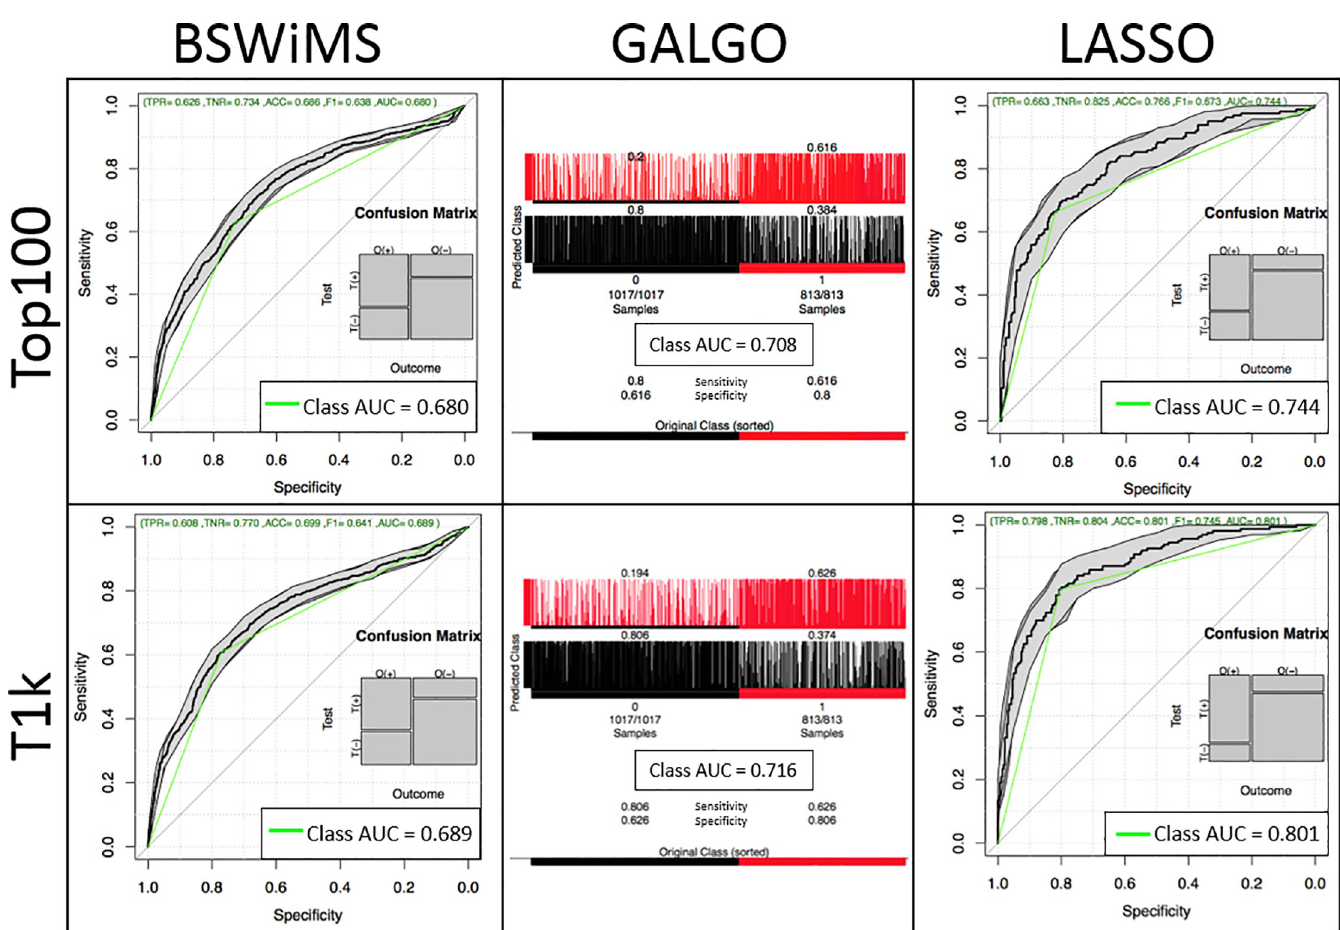
Fig 3. Performance of the three ML methods on two datasets.